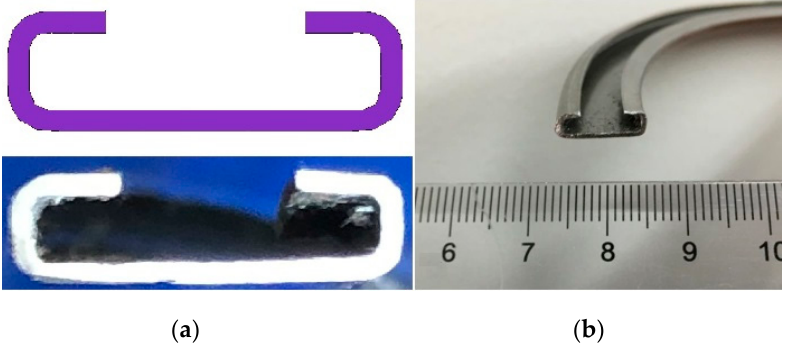
Figure 13. The workpiece after the multi-pass forming. ( a ) First pass; ( b ) second pass.